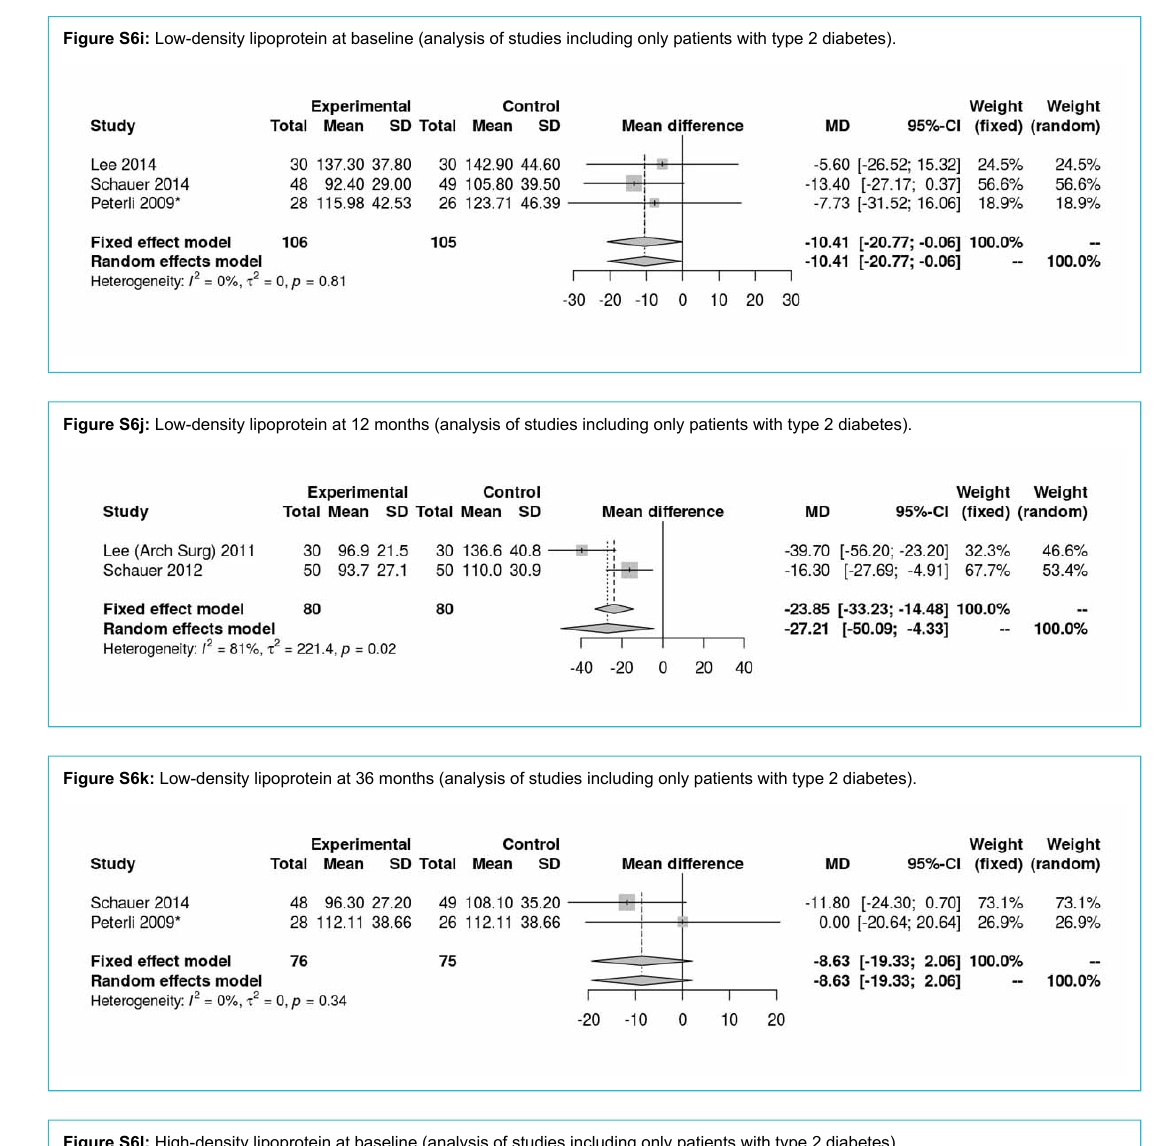
Figure S6l: High-density lipoprotein at baseline (analysis of studies including only patients with type 2